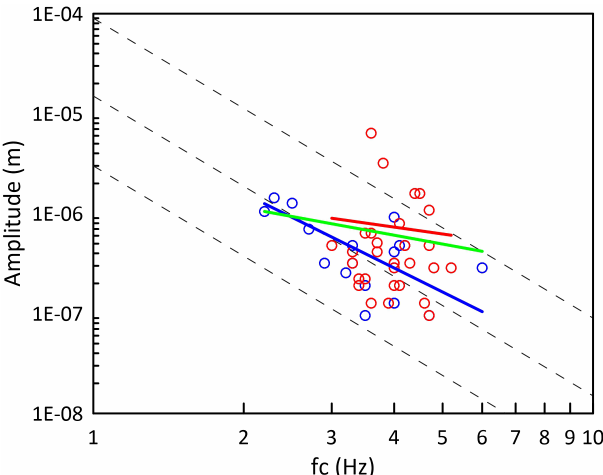
Figure 4. Relationship between the low-frequency level of the am- plitude spectrum, (cid:127) 0 , and corner frequency f c . The data set has been divided in two groups according to the γ value of the spec- tral decay: blue circles for γ ≤ γ T ; red circles for γ > γ T . The best fit lines correspond to the entire data (green) and to the two sub- groups (blue and red); their slopes are 1, 2.6 and 0.7, respectively. The black dashed lines indicate the theoretical slope ∼ f − 3 c